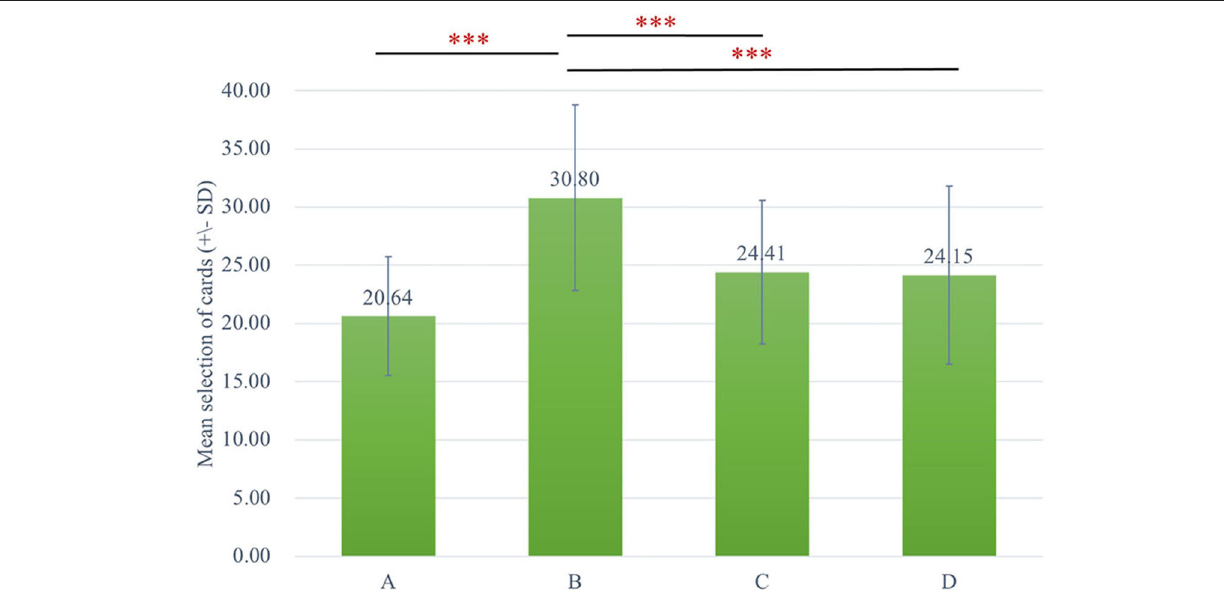
FIGURE 2 | The selective pattern of Sz. Green bars represent the four-deck format of the Sz group, and the number of selections from deck B is significantly larger than the other three decks. *** p < 0.001.